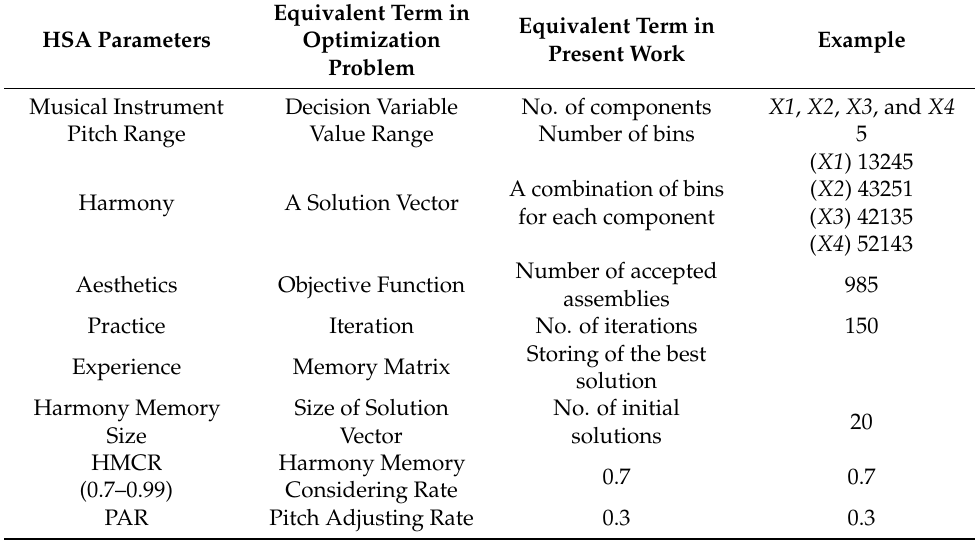
Table 4. Representation of variables in